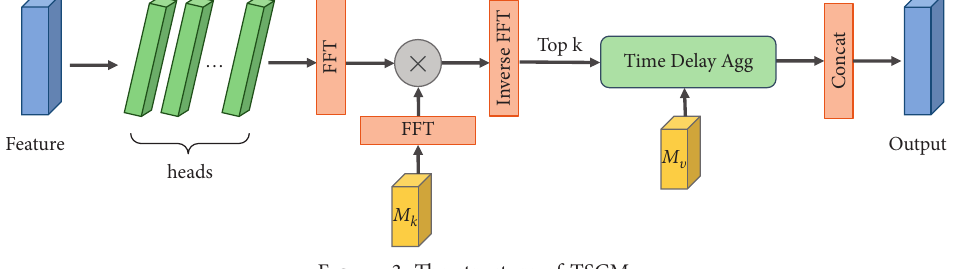
Figure 3: The structure of TSCM.